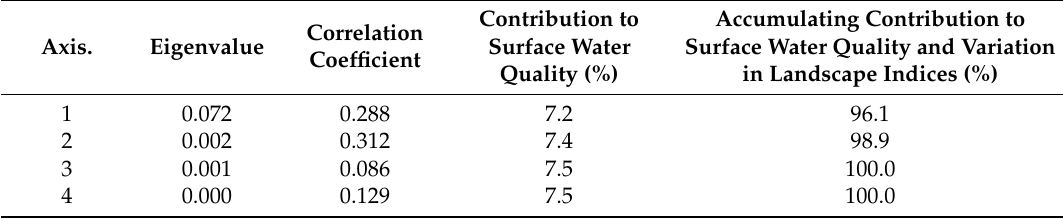
Table 6. Redundancy analysis (RDA) results of landscape indices and surface water quality indicators.